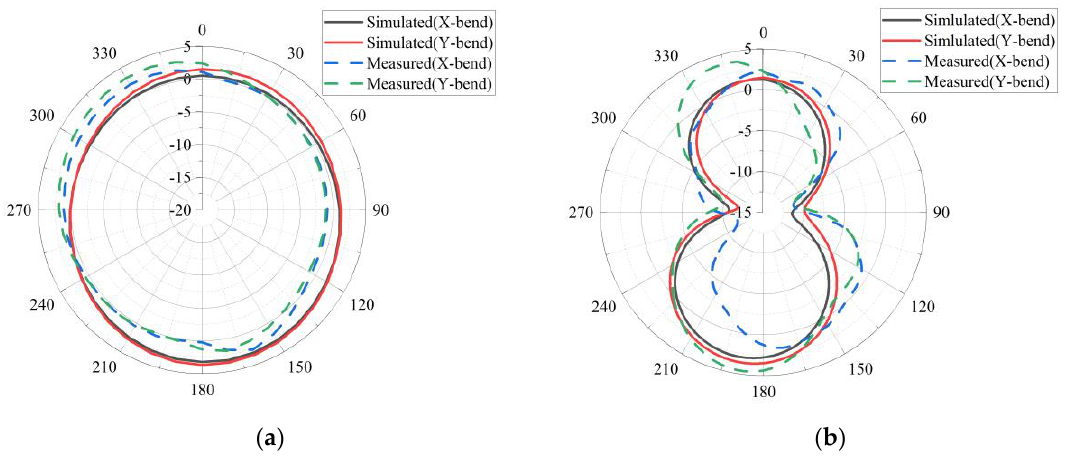
Figure 13. Simulated and measured radiation patterns after structural deformation in the ( a ) xoz-plane and ( b ) yoz-plane.